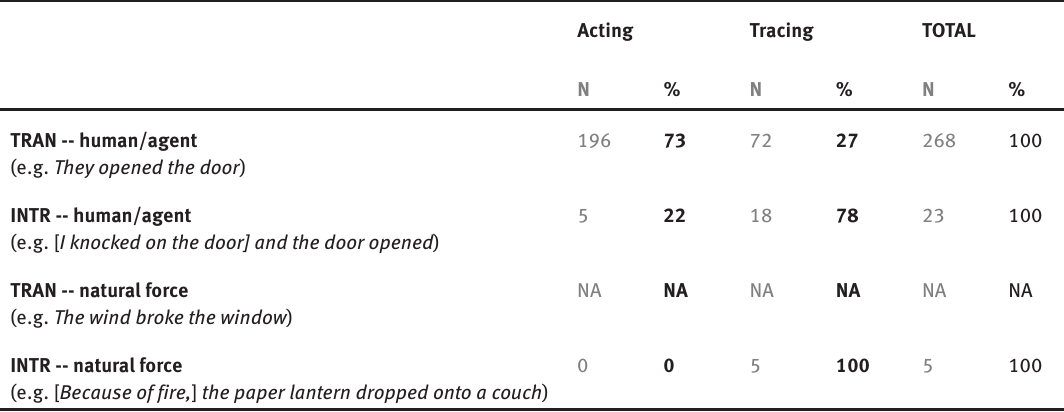
Table 3. Gestural Modes of Representation with respect to the causative-inchoative alternation with human or the natural force as external